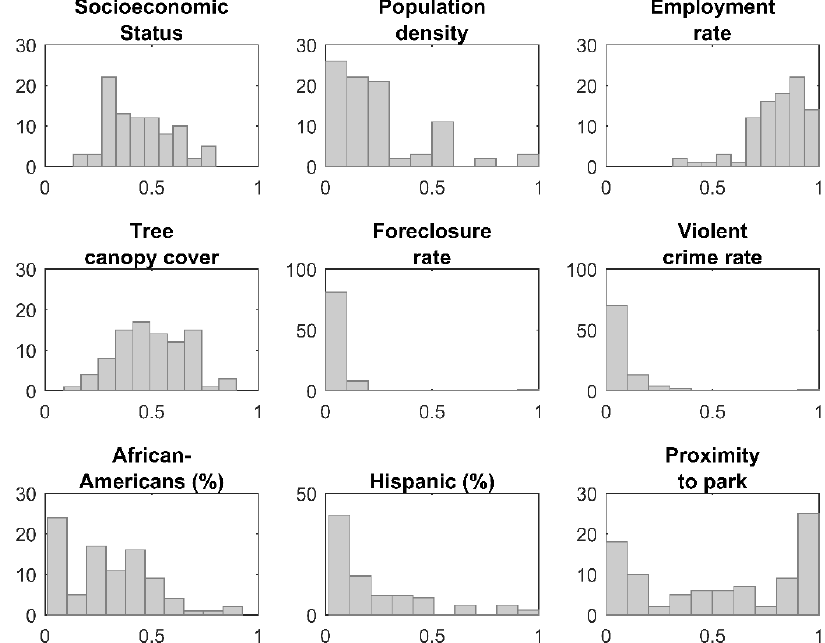
Figure 4. Histogram for each of nine variables using the 90 sites selected in the optimization process (x-axis: standardized variable value; y-axis: count).